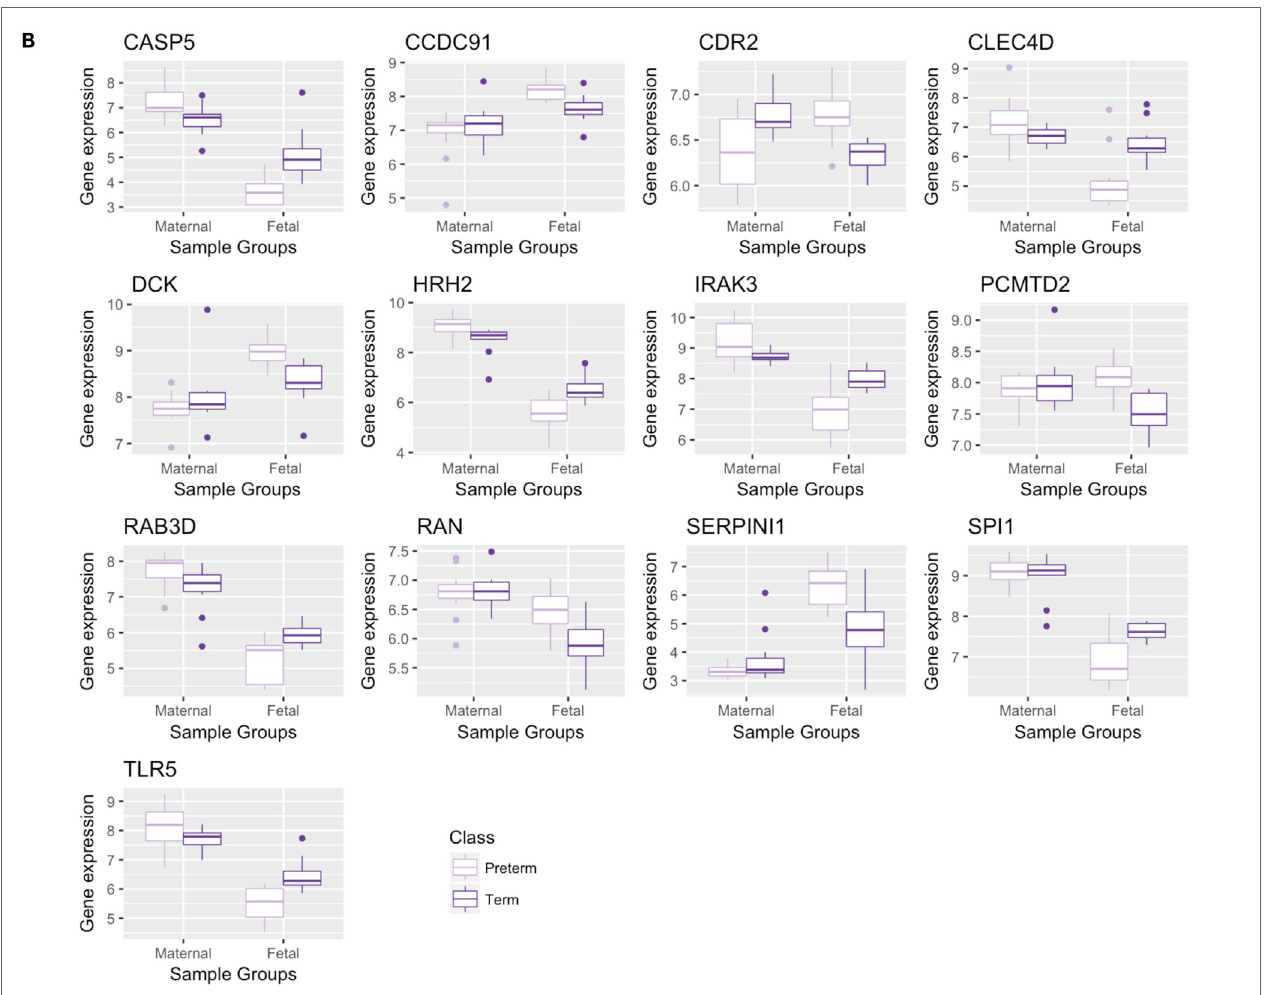
FiGURe 8 | Significant genes from cord blood (CB) tissue analysis and maternal–cord gene signature comparison. (a) Heatmap of significant differentially expressed genes from CB analysis. (B) Boxplot of overlapping significant genes from meta-analysis and CB analysis; raw gene expression values from GSE73685